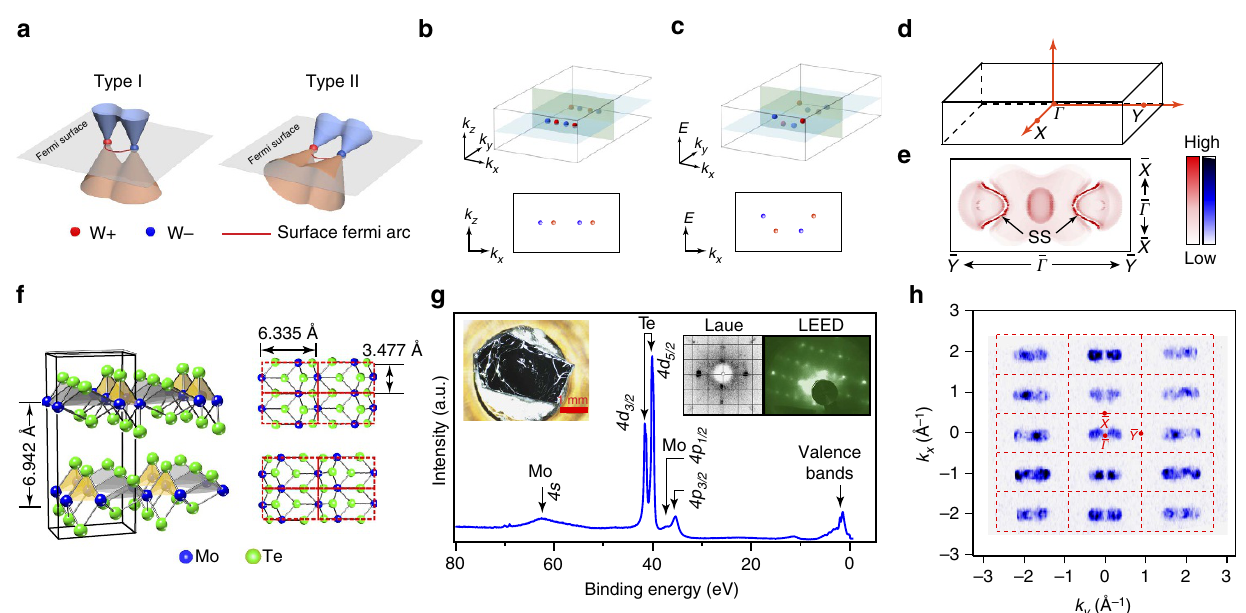
Figure 1 | Basic characteristics of type-II TWS and characterization of MoTe 2 single crystals. ( a ) Schematic illustration of type-I and type-II Weyl fermions and Weyl points in the momentum space. ( b ) Schematic showing the Weyl points of MoTe 2 in a BZ and its projection to the k x – k z plane. ( c ) Schematic showing the Weyl points in the energy–momentum space and their projection to the k x – E plane. ( d ) Illustration of the BZ of T d -MoTe 2 with high symmetry point marked. ( e ) Fermi surface by our ab initio calculation, showing the bulk electron, hole pockets and the surface states (marked as SS). ( f ) Crystal structure of the T d -MoTe 2 , showing alternating ‘ y A-B-A-B y ’ stacking of MoTe 2 layers. ( g ) Core-level spectrum showing characteristic Mo 4s , Te 4p/4d core-level peaks. Left inset: cleaved surface of MoTe 2 single crystal used in this study. Right insets: Laue and low-energy electron diffraction (LEED) pattern showing the T d phase of MoTe 2 . ( h ) Broad-range photoemission spectral intensity map of the Fermi surface (FS) covers 4 10 BZs, showing the correct symmetry and the characteristic FS.